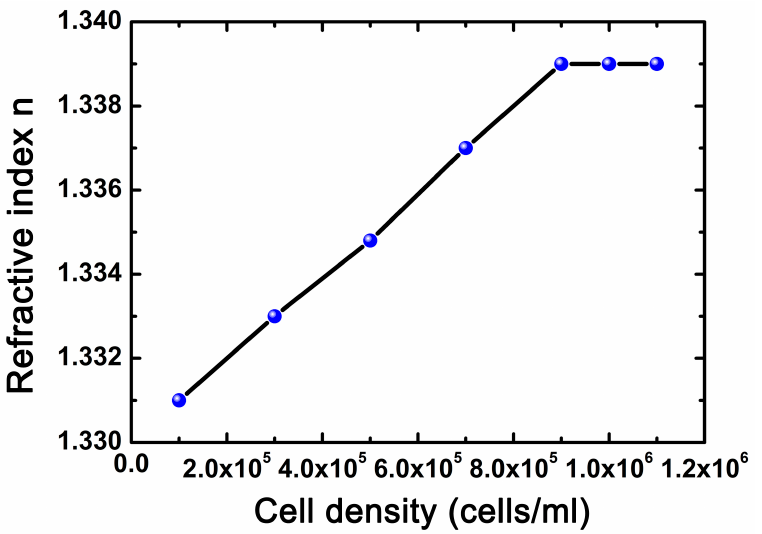
Figure 13. The variation of RI with the change in cell density.